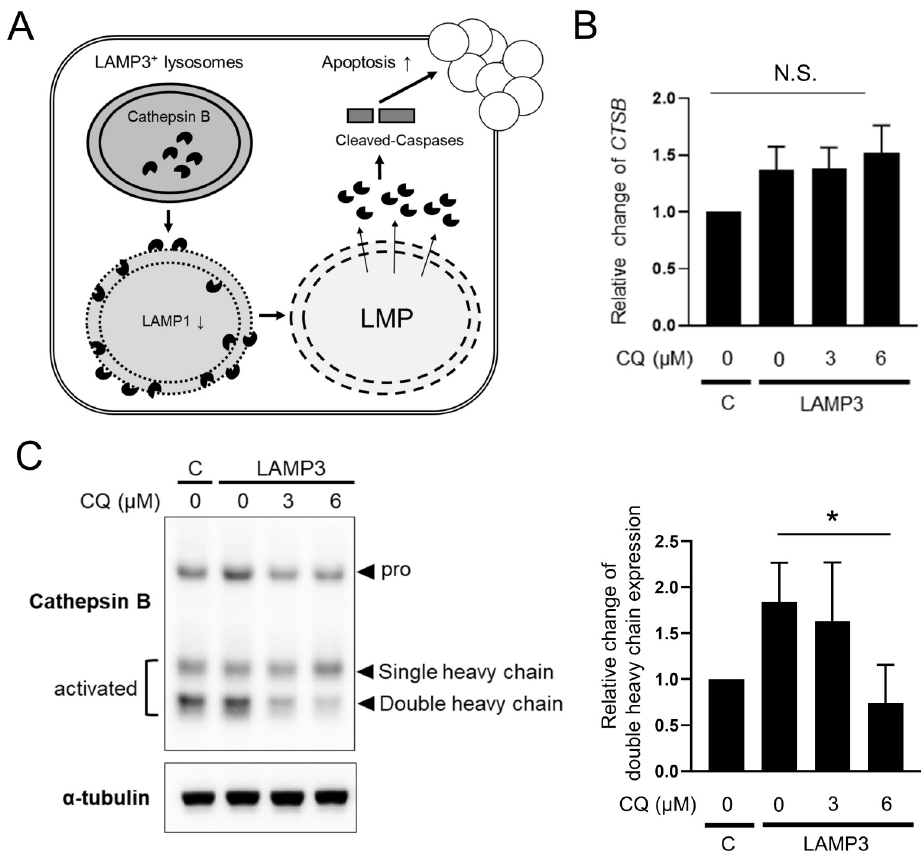
Fig 1. Chloroquine deactivate cathepsin B in LAMP3-overexpressing cells. Stably LAMP3-overexpressing A253 cells were treated with chloroquine (CQ) for 24 hours at increasing concentrations. ( A ) Molecular mechanism about LAMP3-induced apoptotic cell death. ( B ) Relative change in CTSB expression ( n = 4). C: control A253 cells. ( C ) Representative Western blots showing expression of cathepsin B and α -tubulin (control). Bar chart shows relative change of cathepsin B expression normalized by α -tubulin expression compared to control A253 cells ( n = 3). � P < 0.05, N.S. = not significant (Student’s t -tests with Dunnett’s correction).